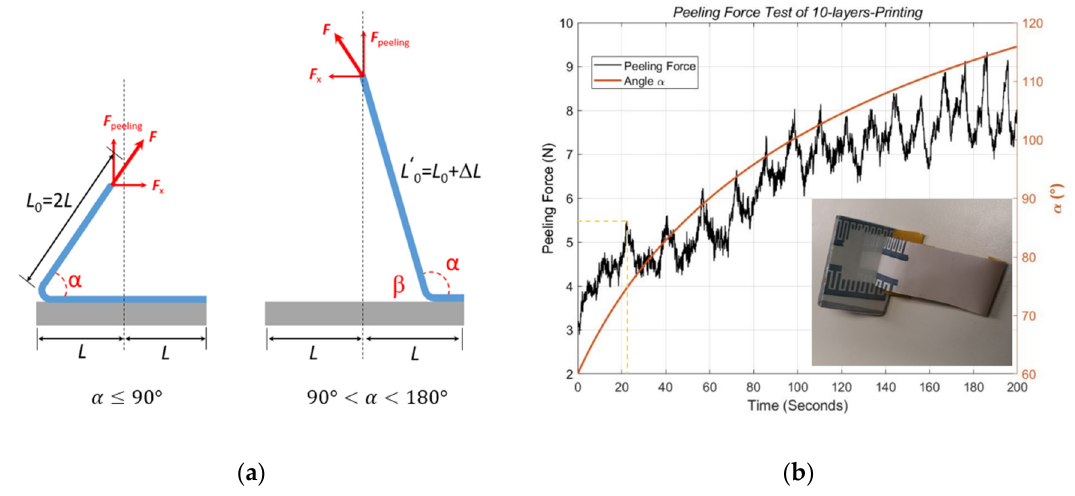
Figure 7. Schematic: ( a ) peeling force test related to angle α . The tape is of length 4 L. ( b ) Measured results of a 10-layer printed sample at a constant speed of 10 mm/min.